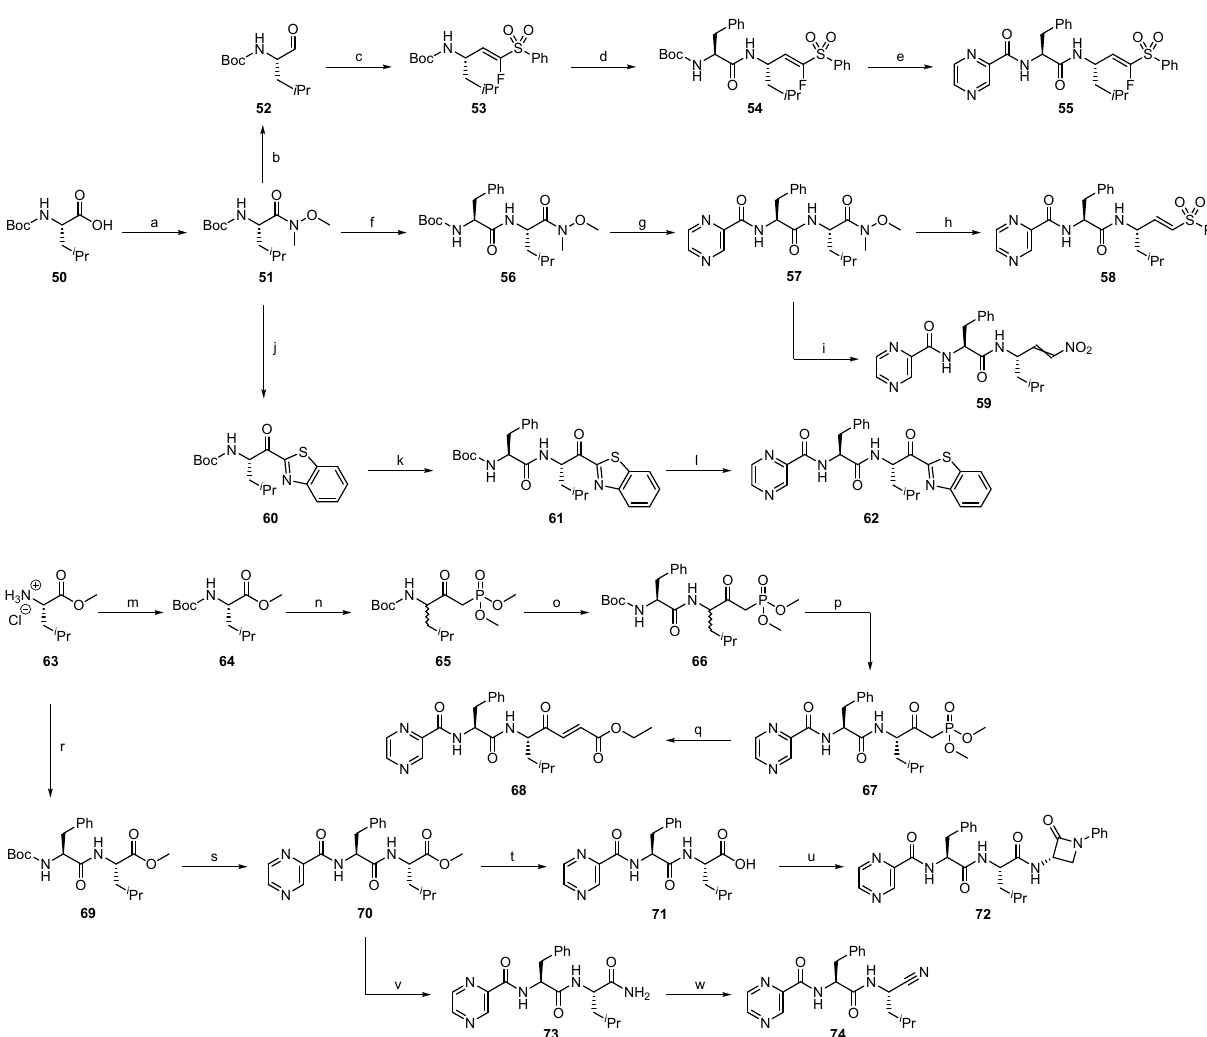
Scheme 4. Synthesis of proteasome β 5-subunit compounds. Reaction conditions: (a) N , O -dime-